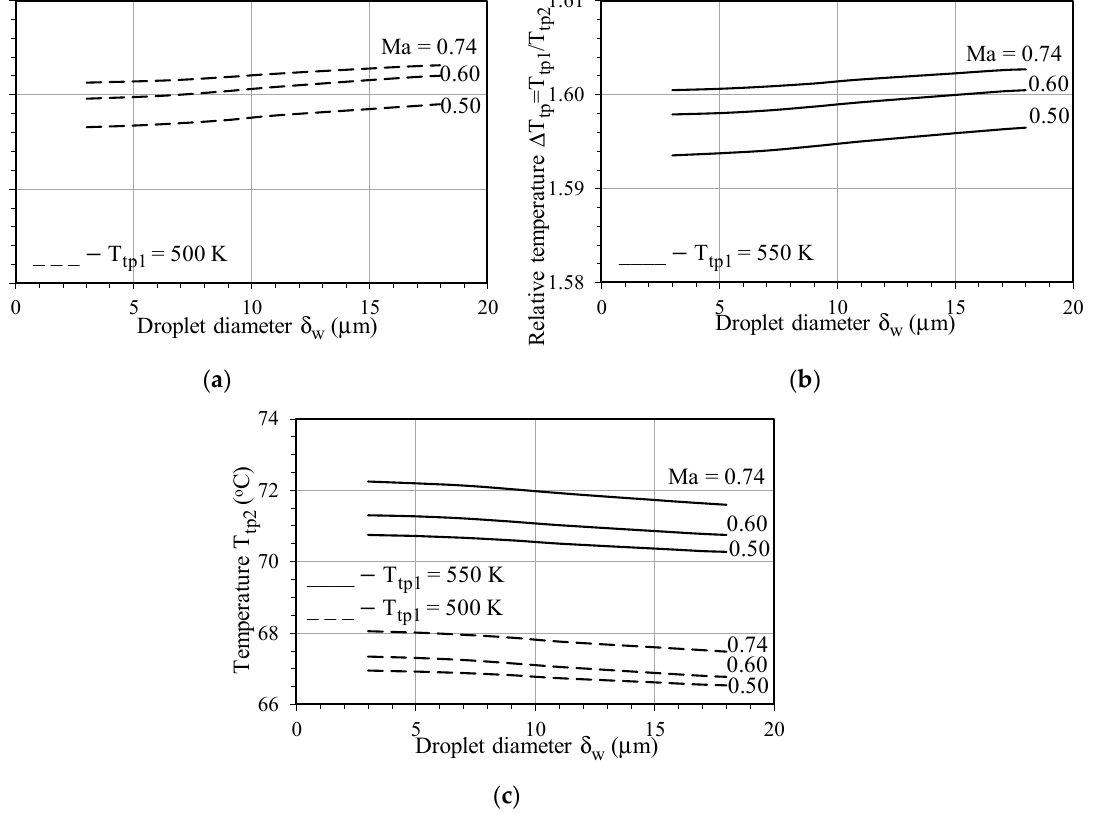
Figure 8. Dependences of the relative temperature, T tp1 /T tp2 , at the T tp1 = 500 K ( a ) and at the T tp1 = 550 K ( b ) and temperature at the end of the thermo-gas-dynamic compression process, T tp2 , ( c ) on the droplet diameter, δ w , at different air temperatures at the inlet. Depending on the initial parameters (air temperature, Mach number at the evaporation chamber inlet and droplet diameter), the humidified air temperature at the evaporation chamber outlet decreases: at T tp1 = 500 K, it decreases by ∆ T tp = 160–165 K; at T tp1 = 550 K, by ∆ T tp = 207–212